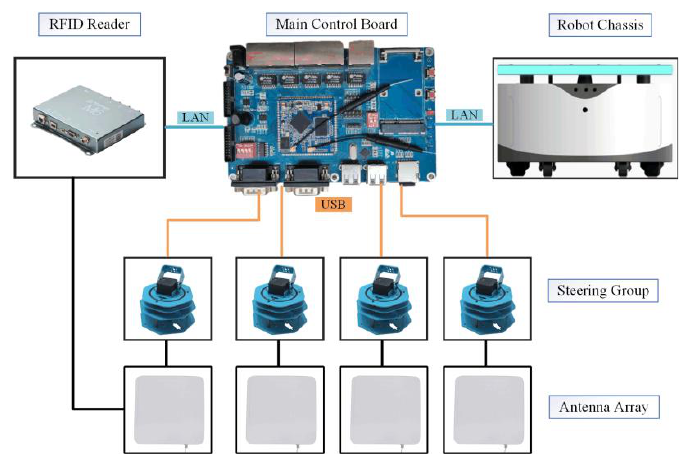
Figure 1. Hardware topology of RFID robot systems.